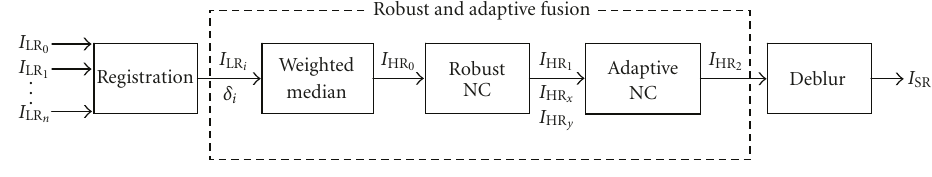
Figure 1: Flow diagram of Pham’s structure-adaptive and robust SR reconstruction method.